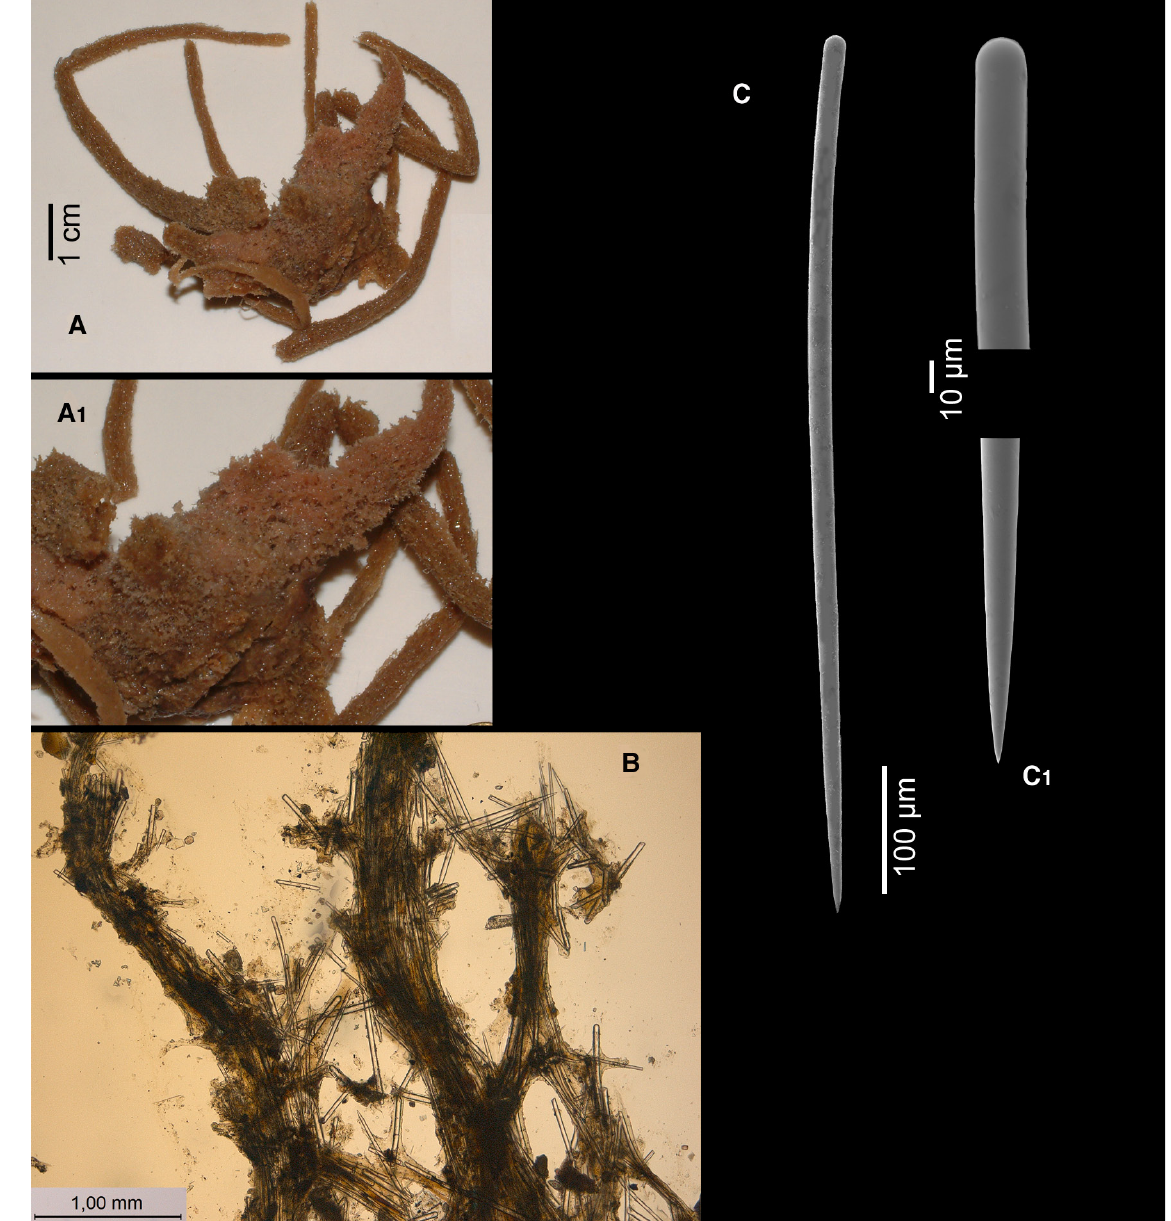
Fig. 8. Ulosa capblancensis sp. nov., Holotype ZMA Por. 09959. A . Habit. A B . Cross section of skeleton. C . SEM image of style. C